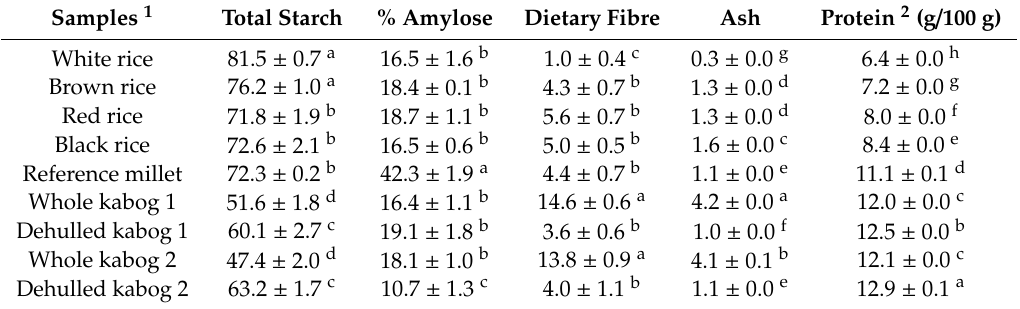
Table 1. Total starch, % amylose, dietary fibre, ash, and total protein content of rice (white, brown, red, and black), reference millet, and kabog millet (whole and dehulled) samples expressed as